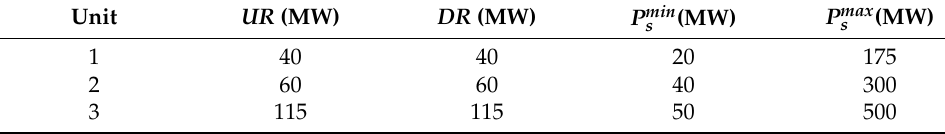
Table 5. Basic parameters of thermal power units.